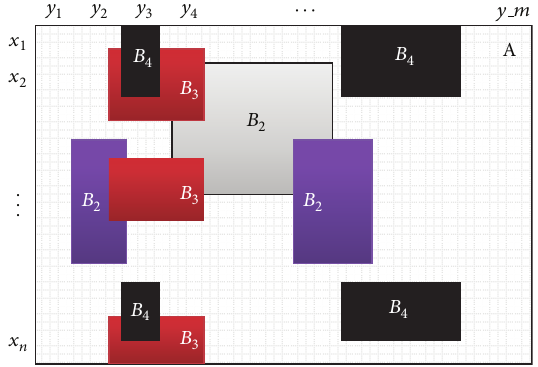
Figure 1: Illustrative representation of biclusters/frequent closed itemsets on binary